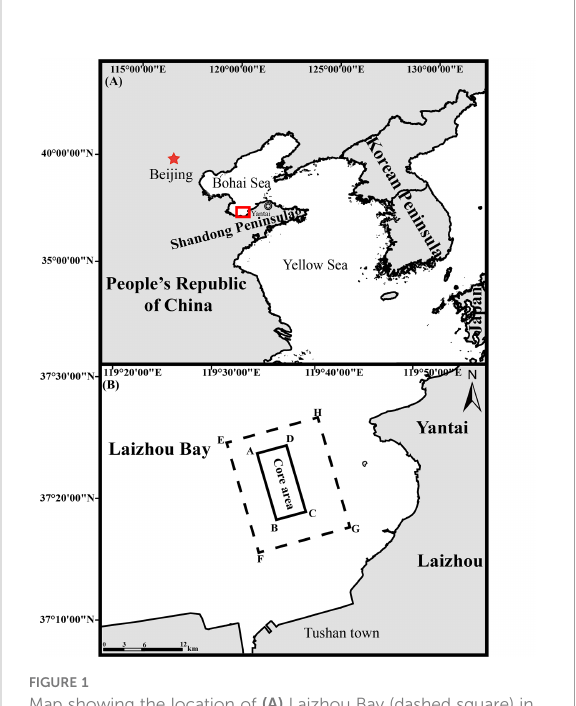
FIGURE 1 Map showing the location of (A) Laizhou Bay (dashed square) in the People ’ s Republic of China and (B) the model domain of Laizhou Bay marine ranching area (EFGH — dashed rectangle) and the core area for implementing stock enhancement (ABCD — solid